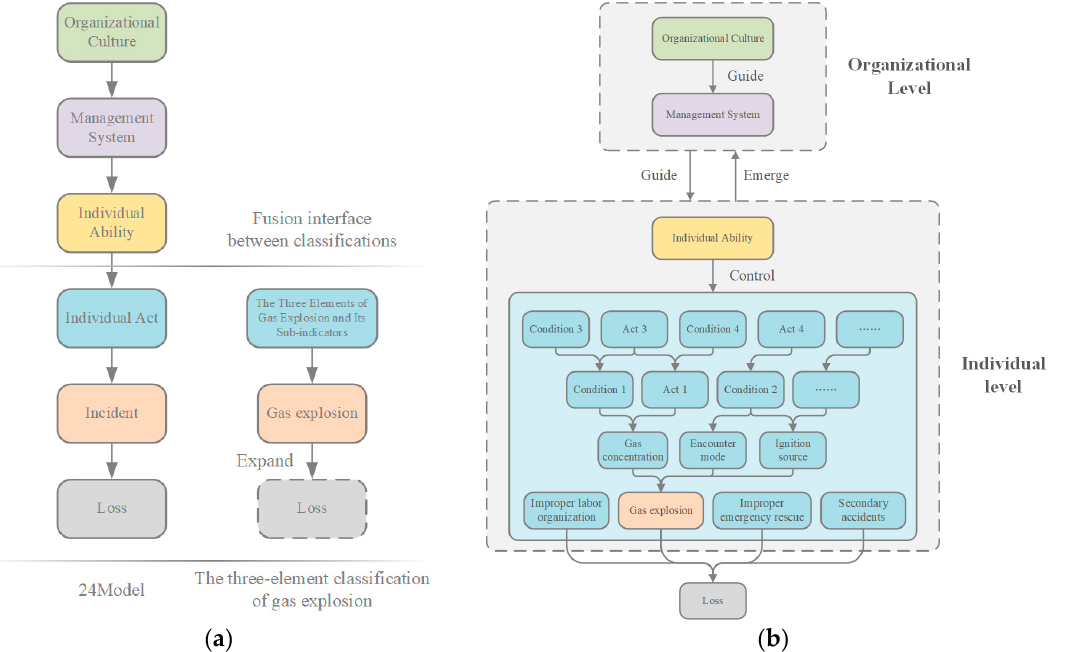
Figure 3. ( a ) Fusion interface between the 24Model and the three-element classification of gas ex- plosions; ( b ) basic structure of the composite classification. explosions; ( b ) basic structure of the composite